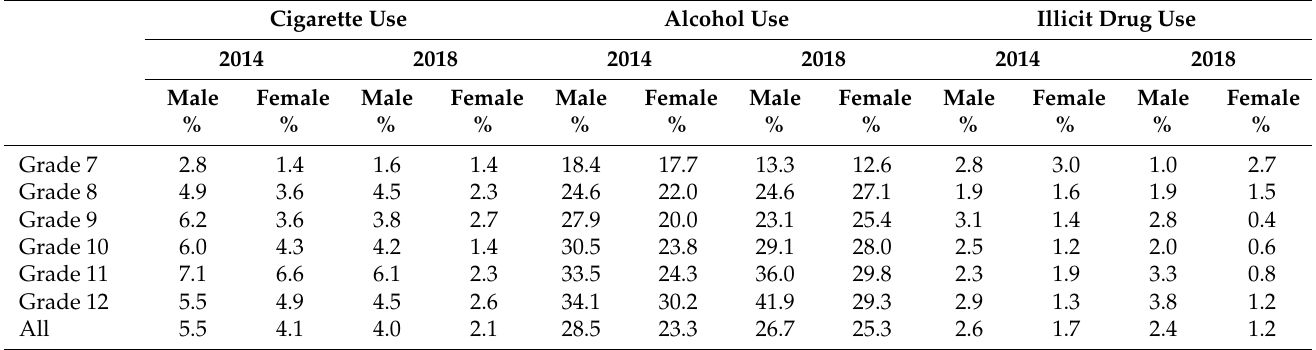
Table A2. Past 30-day use of cigarette, alcohol and illicit substance by gender and grade in 2014 and 2018.